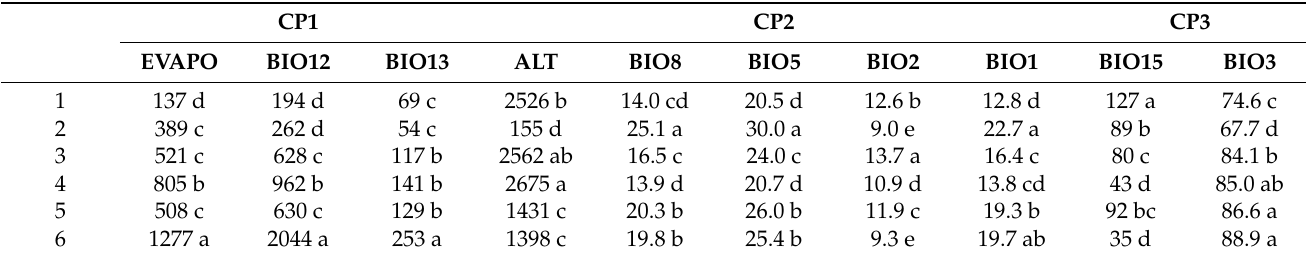
Table 4. Medians comparisons of the informative variables that integrate the first three principal components for the 6 clus- ters formed in the CA of the wild tomato species in Latin America. EVAPO = Annual evapotranspiration, BIO12 = annual pre- cipitation, BIO13 = precipitation of wettest month, ALT = altitude, BIO8 = mean temperature of wettest quarter, BIO5 = max- imum temperature of warmest month, BIO2 = mean diurnal range, BIO1 = annual mean temperature, BIO15 = precipitation seasonality, and BIO3 =